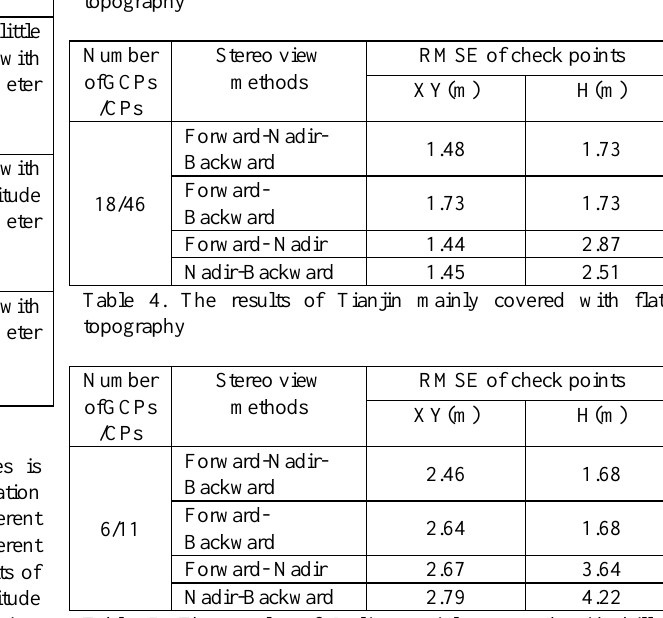
Table 5. The results of Dalian mainly covered with